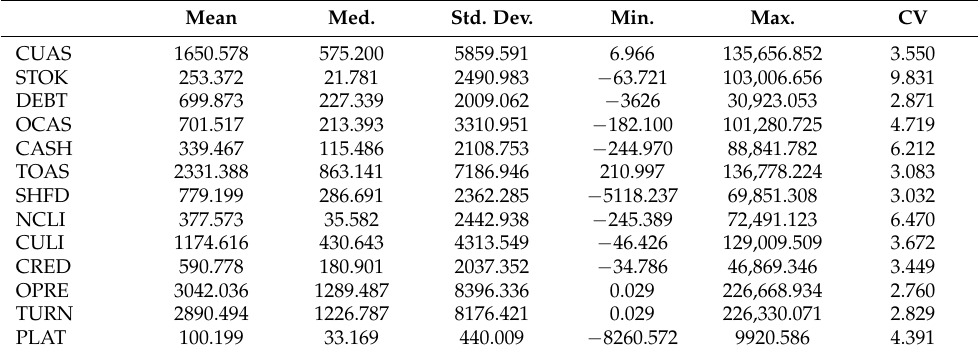
Table 2. Descriptive statistics of individual financial indicators (values are given in thousands of